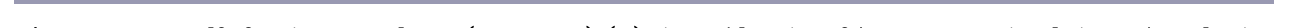
Fig. 1 . Western Gulf of Maine Area Closure (WGoMAC): (A) Size and location of the WGoMAC in relation to the Atlantic cod ( Gadus morhua ) essential fish habitat (EFH) for juvenile and adult stages. Data on EFH obtained from the NOAA Fisheries, Office of Habitat Conservation. (B) Area Closure (AC) proposals during the development process of the WGoMAC. Jeffrey’s Ledge AC (purple) and Six-month AC (green) were substituted by WGoMAC (red) as the final measure. Numbered squares (30 ft) are statistical units used for reporting landings.